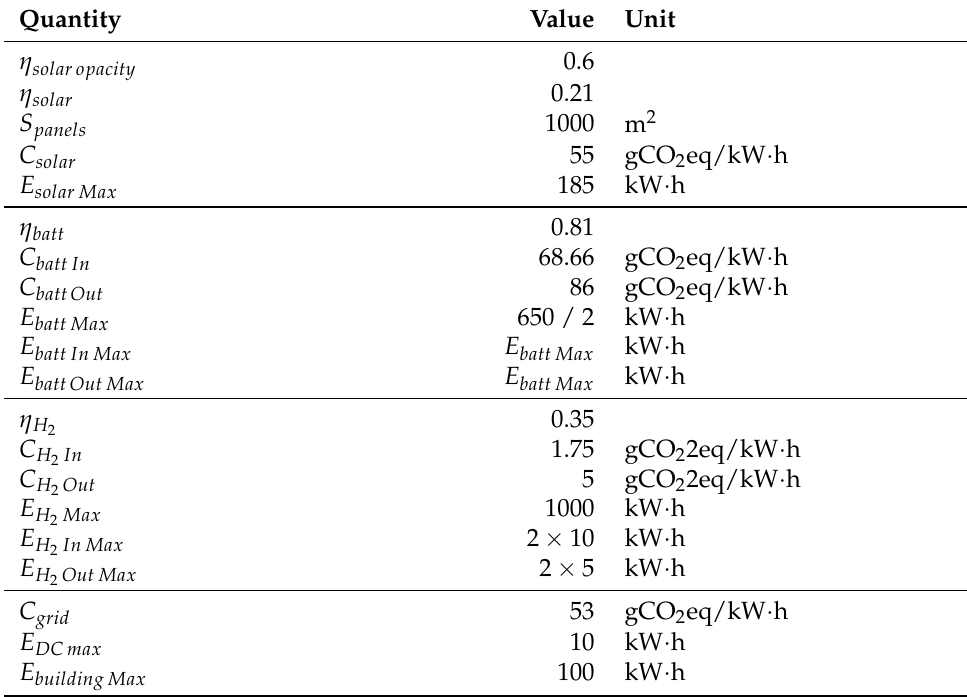
Table 3. Parameters values used during